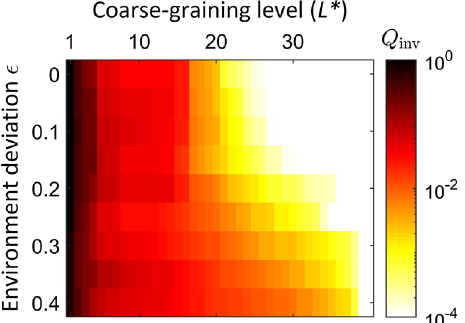
FIG. 7. A coarse-graining scheme works best when the envi- ronment is populated by the native strain pool. The same test environment as in Fig. 5(a) is inoculated with strain pools that evolve in environments increasingly further away (see the text). The coarse-graining quality is assessed by leave-one-out experi- ments and shown as a function of L (cid:3) and environment deviation ϵ from the test condition. L is fixed at L ¼ 40 for comparison with the last row in Fig. 5(a). As the environments for generating strain pools are modified, the traits that were previously negligible can no longer be coarse-grained. The same random biochemistry as in Fig. 5(a) is used, and each pixel is averaged over 20 random FIG. 6. Replicate communities assembled in similar environ- ments are more reproducible at coarser level of description. (a) A ⃗ K set of similar environments þ ⃗ ϵ (each carrying capacity modified by 10% Gaussian noise) is inoculated with the same strain pool and brought to ecological equilibrium. (b) Equilibrium relative abundances of coarse-grained L (cid:3) -types across 20 replicates, shown for two levels of coarse-graining. A coarser description ( L (cid:3) ¼ 5; 7 resolved types) is more reproducible, consistent with experimental observations [13]. (c) The variabil- ity of coarse-grained descriptions increases with the level of detail. Variability is measured as the average coefficient of variation (CV) in relative abundance of an L (cid:3) -type over 100 replicates, weighted by L (cid:3) -type mean relative abundance across replicates. Dashed lines mark L (cid:3) ¼ 5 , 30 shown in (b). Data points and shading show mean (cid:4) SD over 20 random choices of biochemistry f J ij g . All simulations performed with L ¼ 40 .